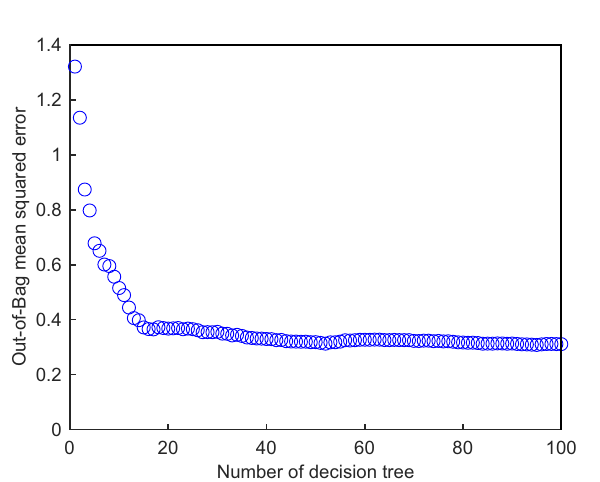
Figure 17. Flow chart of the random forest.